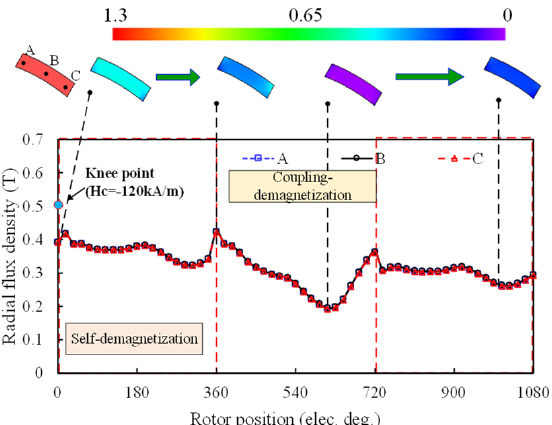
Figure 3. Variation of the working point of PM elements subject to one electrical period of q -axis current excitation ( I q = 14.14A).